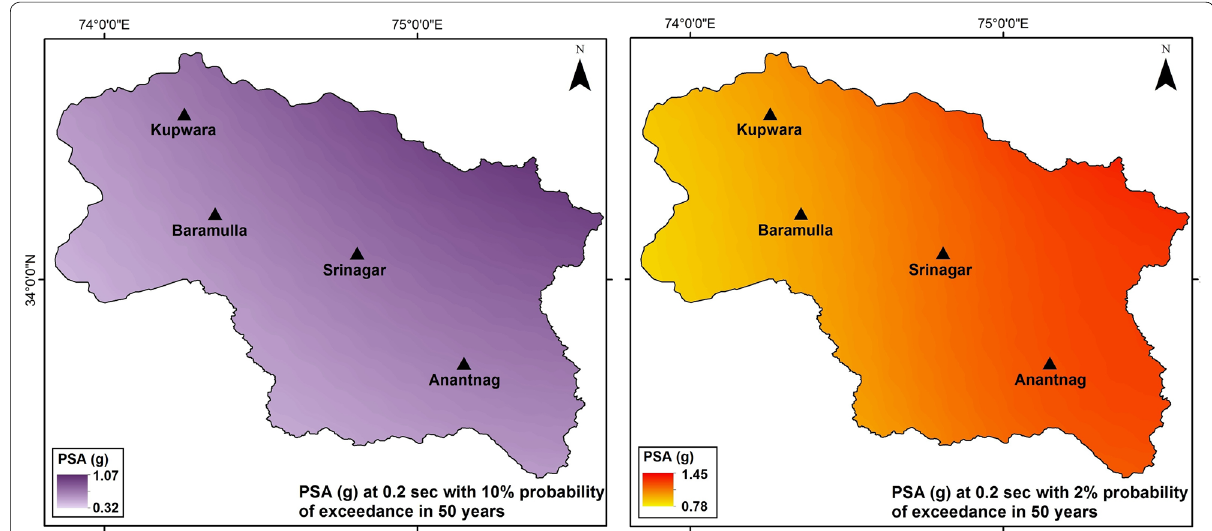
Fig. 7 The seismic hazard maps showing predicted pseudo spectral acceleration (PSA) in g at 0.2 s (s) with 2% and 10% probability of exceedance within 50 years for engineering bed rock sites. The sources are faults and seismic sources zones are considered sources for this computation